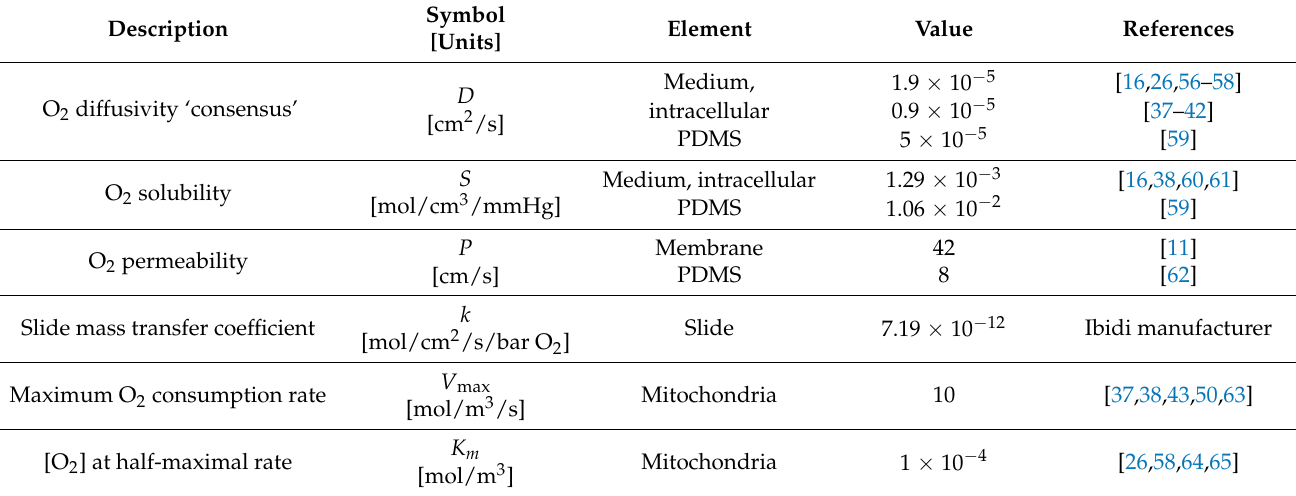
Table 3. Parameters used for